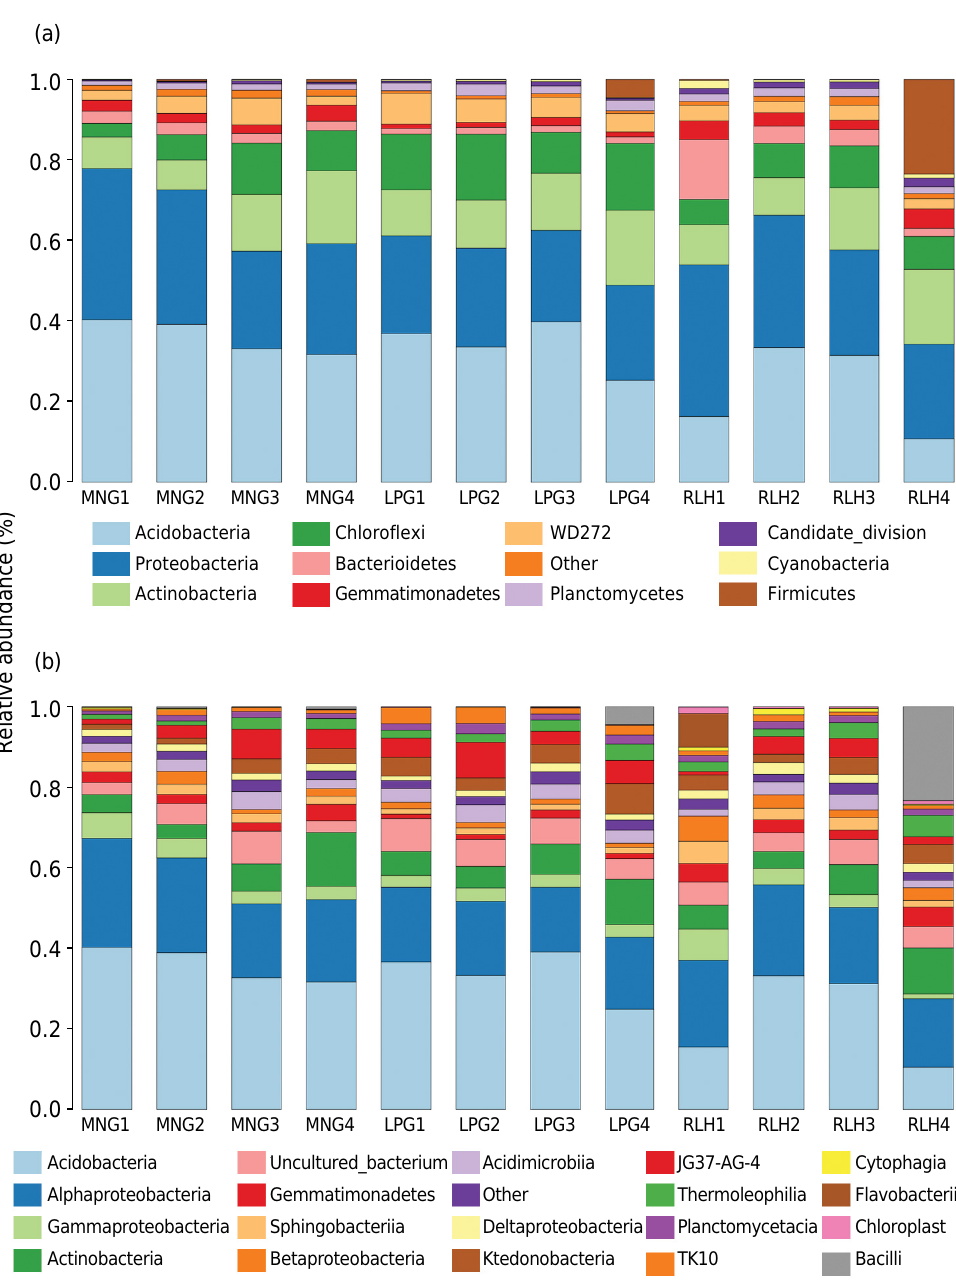
Figure 1. Relative abundance at the bacterial taxonomic levels of different treatments. Note: Bacteria phylum (a); Bacteria class (b). RLH: raising laying hens under forest; LPG: cultivating Lolium perenne grass under forest; MNG: maintenance of native grass under forest. The number after the treatment symbol means: 1 = spring; 2 = summer; 3 = autumn; 4 =